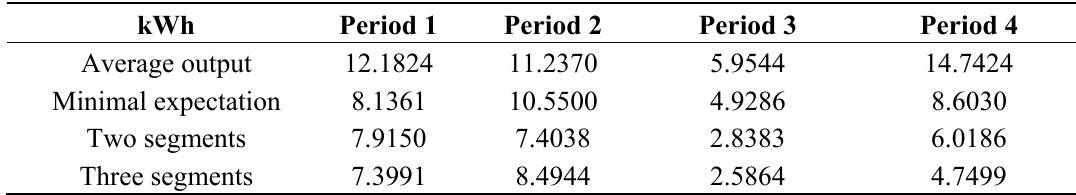
Table 3. Capacity comparison of all